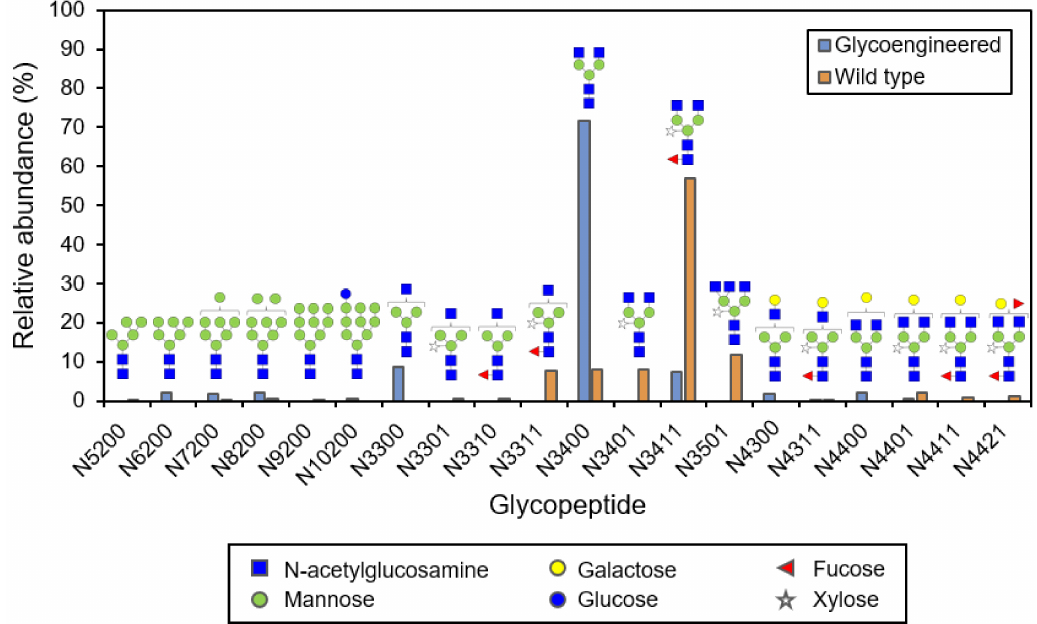
Figure 7. Distribution of N-glycans on CMG2-Fc produced transiently in ∆ XTFT N. benthamiana cell culture (glycoengineered) and through agroinfiltration of wild type N. benthamiana plants (wild type). Labels on the x -axis represent the number of monosaccharides in N-linked glycans in the following order: hexose (mannose, glucose and galactose), N-acetylglucosamine, fucose and